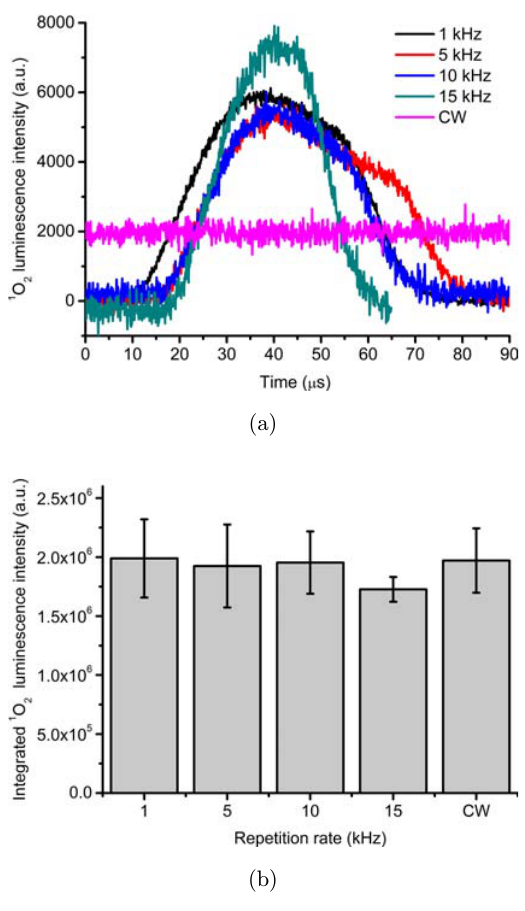
Fig. 5. (a) The typical time-resolved 1 O 2 luminescence ki- netics after background subtraction from RB 1.00 (cid:1) M in PBS, and (b) the corresponding time-integrated 1 O 2 luminescence intensity with repetition rates of 1, 5, 10, 15 kHz and CW at 532